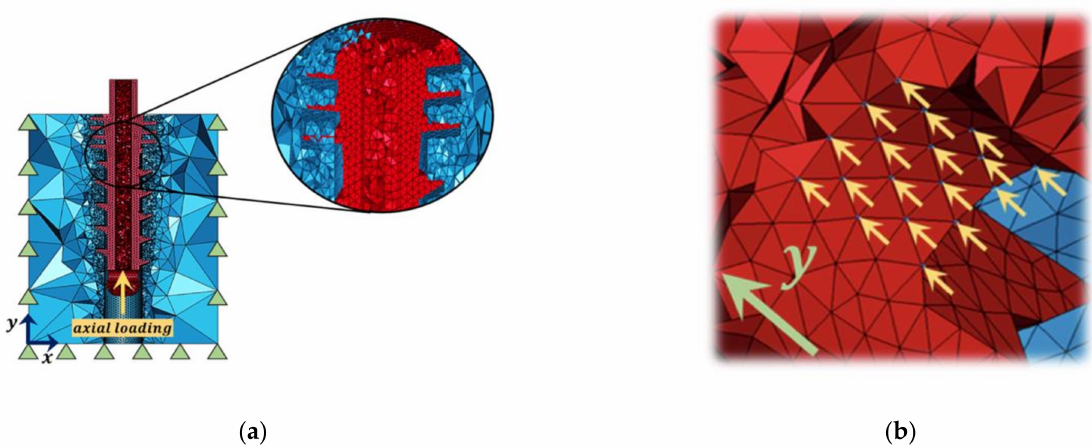
Figure 3. FE Mesh of a suture anchor and a PU (bone) block. ( a ) Entire model and its local mesh; ( b ) contact forces of the interface and their direction.